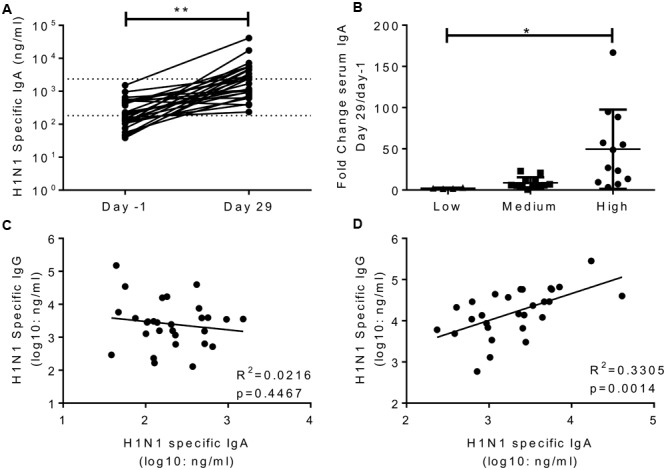
Infection with influenza increases H1 serum IgA antibody responses. Healthy adult human volunteers were infected intranasally with different doses of H1N1 influenza. H1 specific IgA responses were measured by ELISA in serum on day-1 and day 29 of infection and presented as absolute values (A) and fold change based on the infecting dose (B). Serum IgA and IgG were compared at day-1 (C) and day 29 (D). Data from a single study n = 29 volunteers.